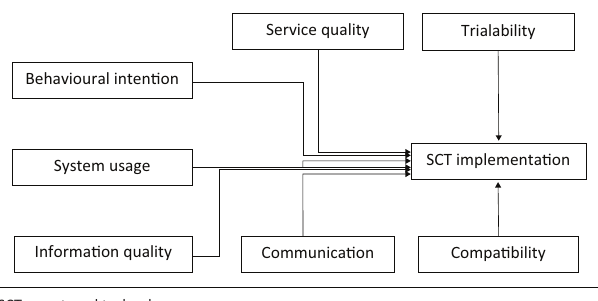
FIGURE 3: Final model for the critical success factors for the adoption of smart card technology in South African public hospitals.